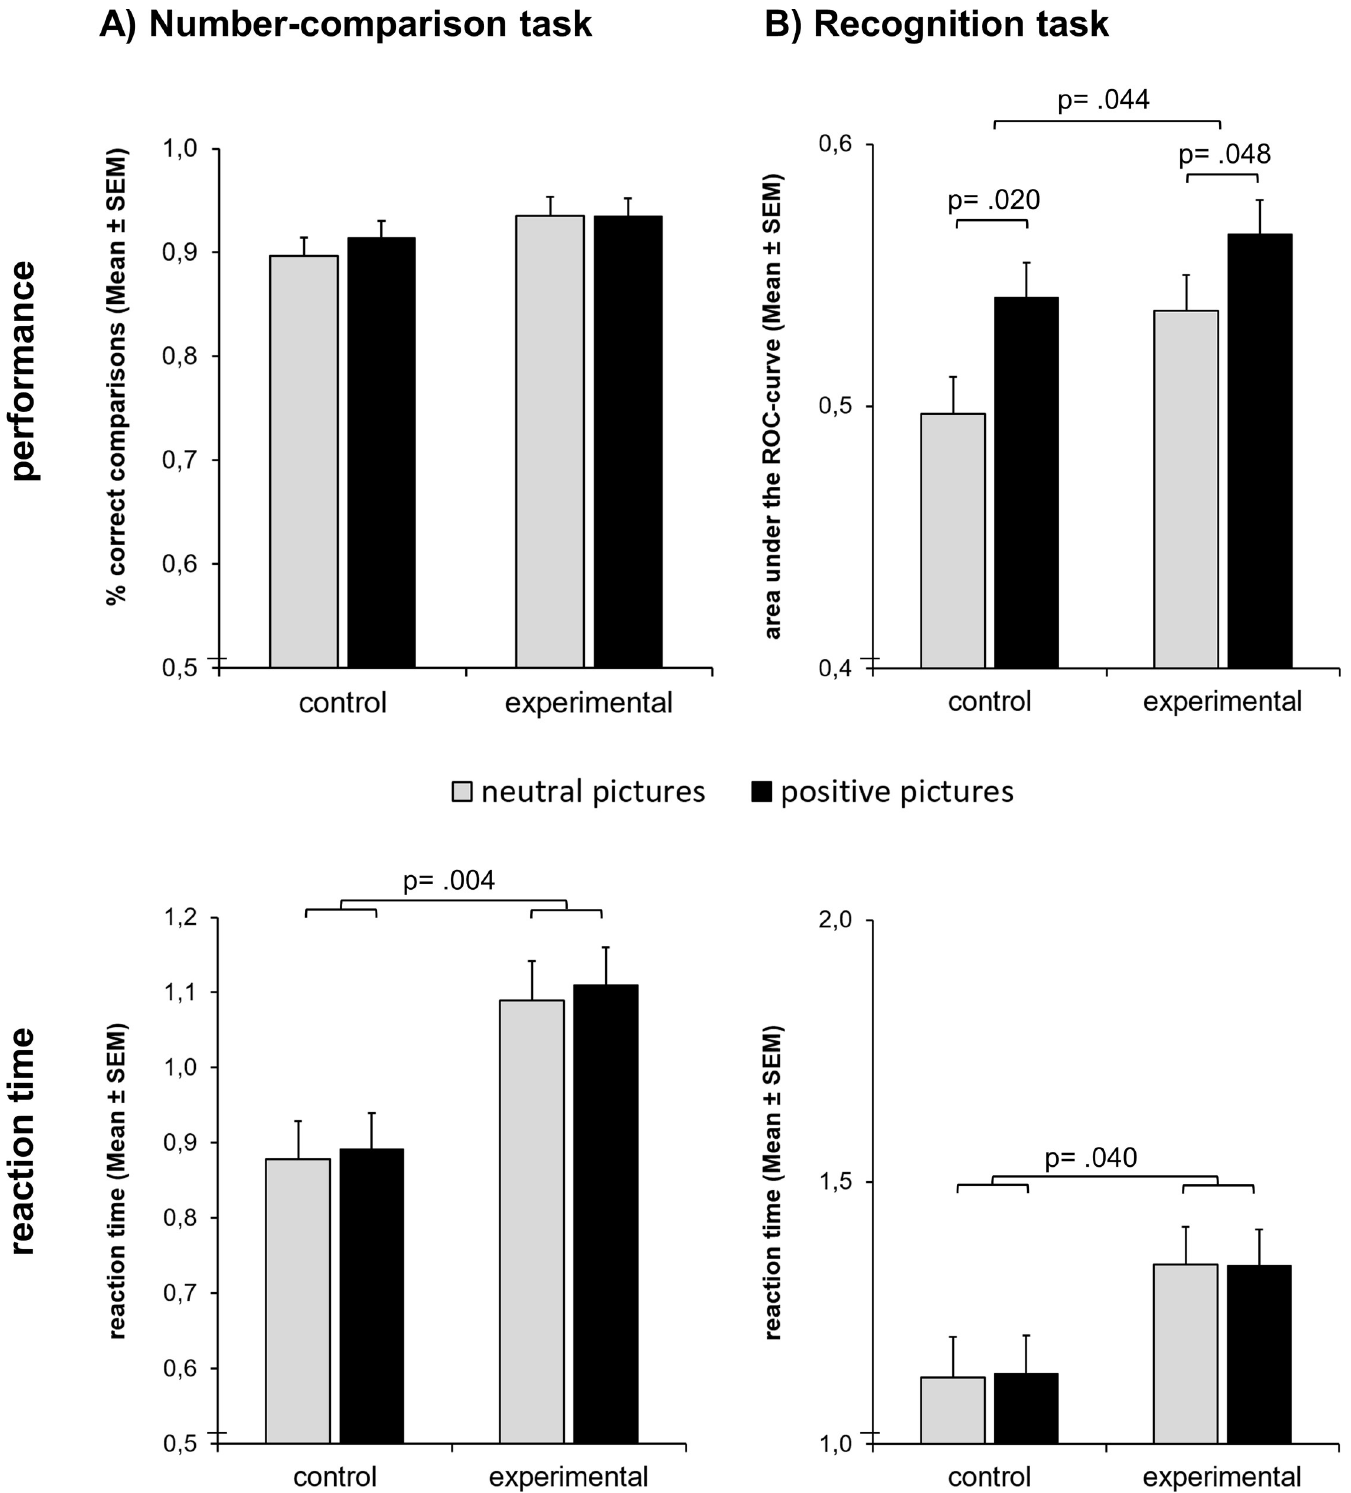
Fig 2. Results. A) The cost of self-control failure is reflected in an attention shift away from the number-comparison task: Participants of the experimental group who worked on consecutive self-control demanding tasks were slower in the number-comparison task than participants of the control group who had previously worked on the easy control task. B) The benefit of self-control failure is reflected in an attention shift toward the distracting pictures presented during the number-comparison task: